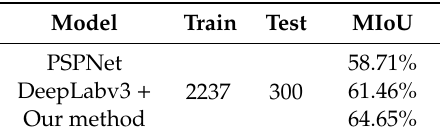
Table 4. MIoU value of the Underwater